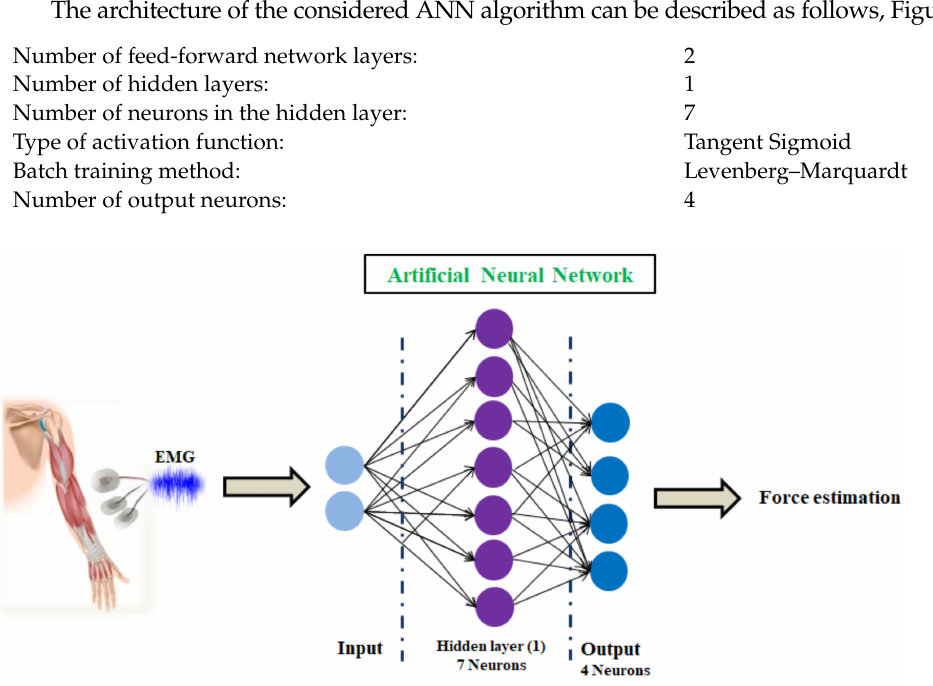
Figure 7. The architecture of the applied ANN